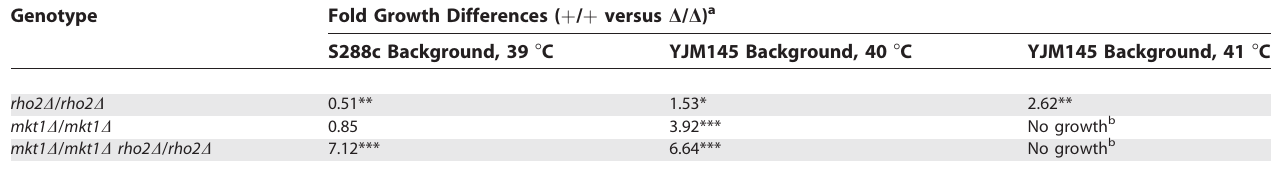
Table 1. Phenotypes of Htg QTG Deletion Strains in the Parental Backgrounds Genotype